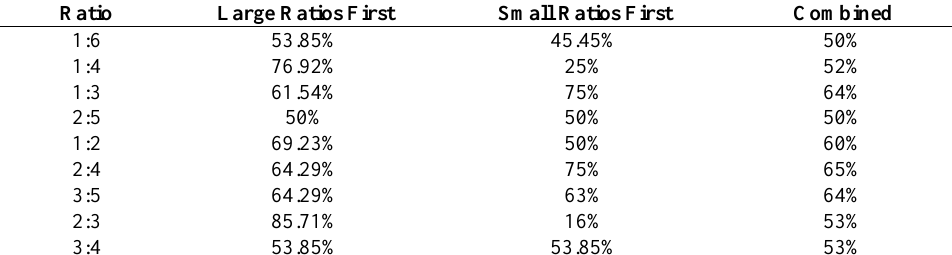
Percentage of Large Choices Made by Ratio Size Group Shown